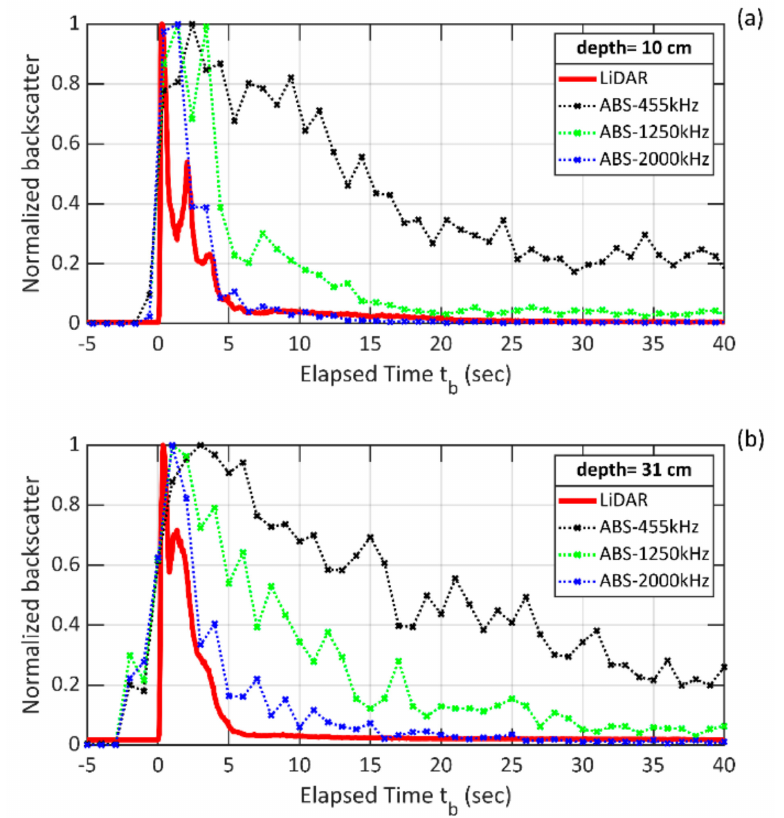
Figure 6. Time evolution of normalized backscatter of LiDAR and ABS data of 455 kHz, 1250 kHz and 2000 kHz at depths ( a ) 10 cm and ( b ) 31